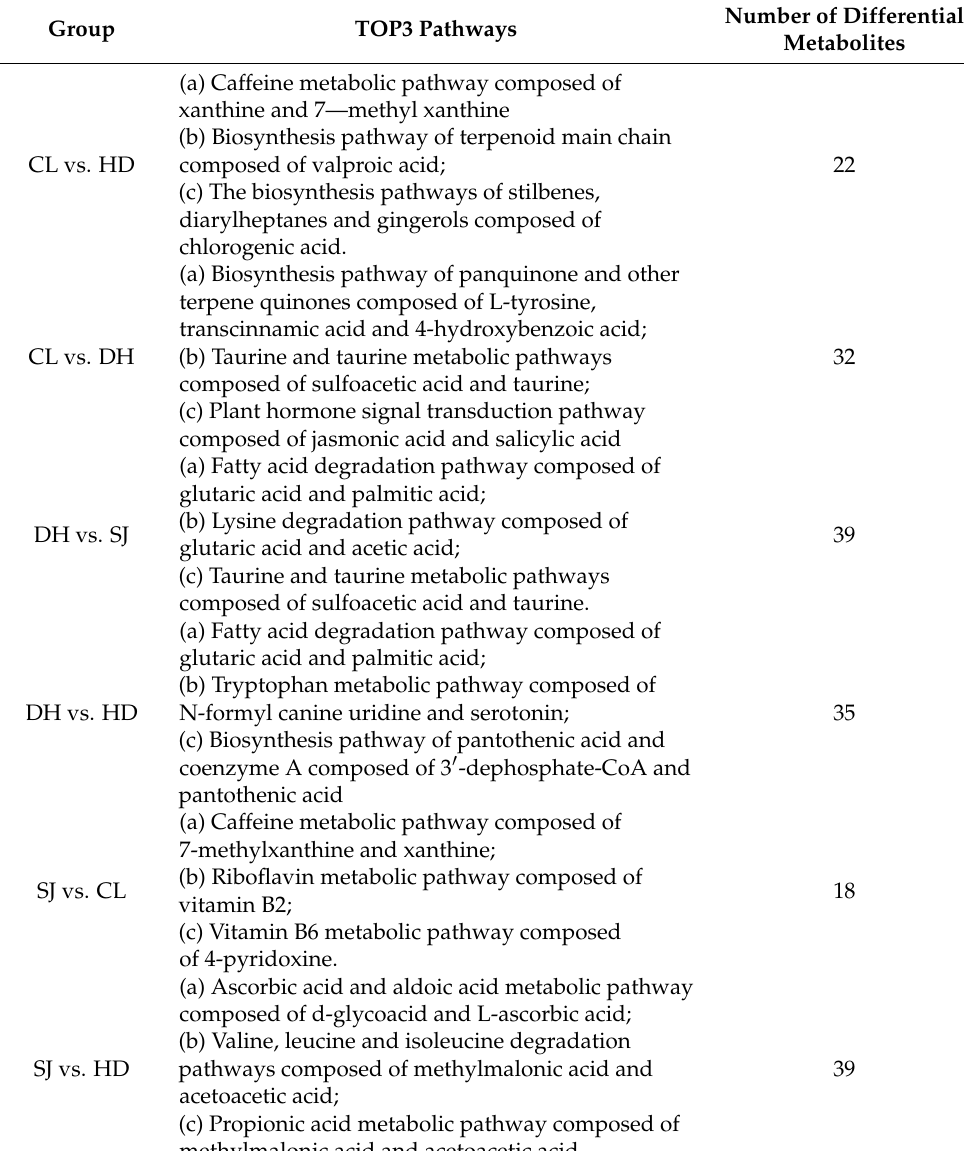
Table 2. Metabolite pathway analysis of rice from different origins. Group TOP3 Pathways